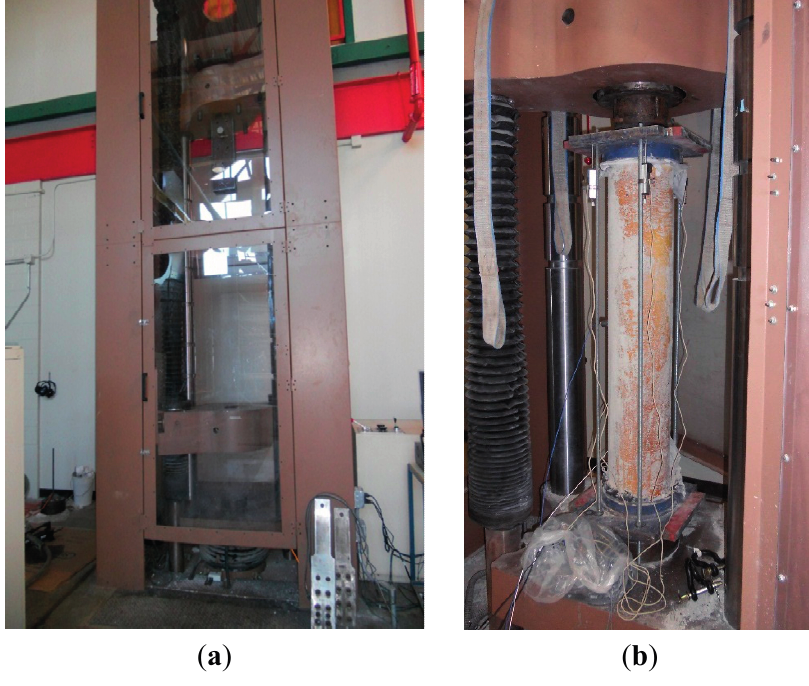
Figure 13. ( a ) Empty 400 kip load frame; and ( b ) CFFT 1-Hr axial load test